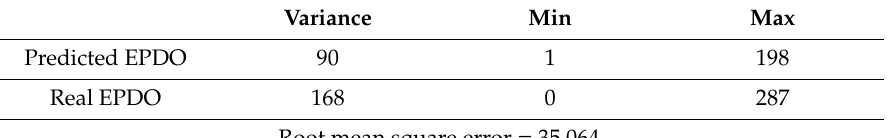
Table 7. Some statistics about predicted and real EPDO based on ZI